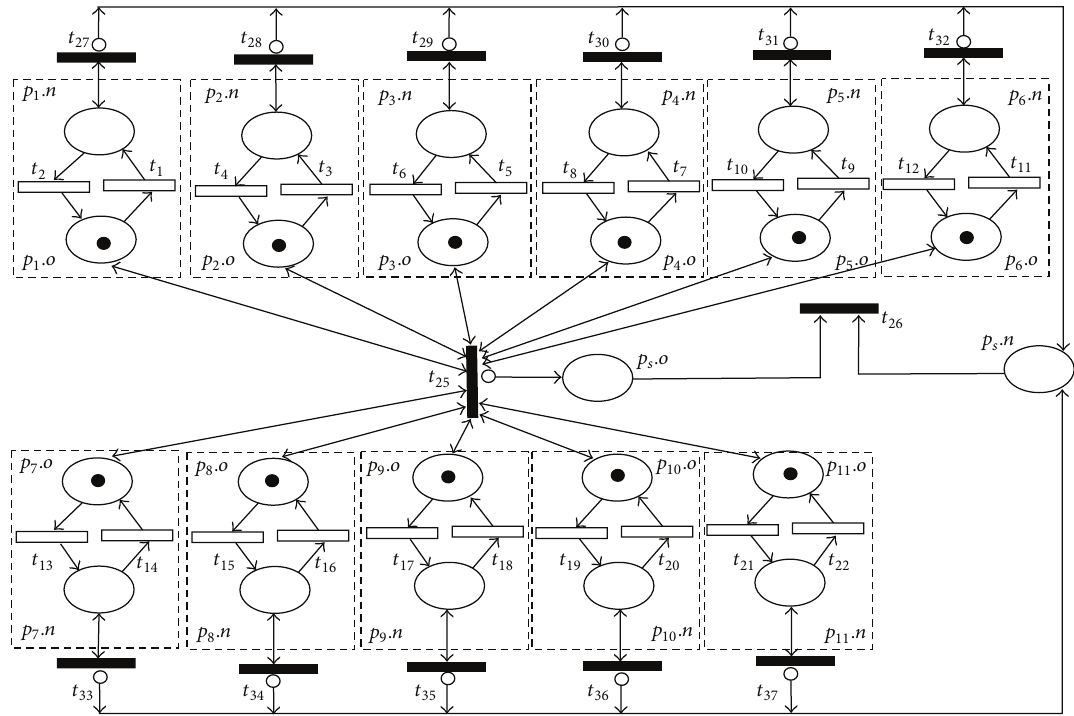
Figure 3: The GSPN model of jet pipe servo valve’s dynamic reliability.